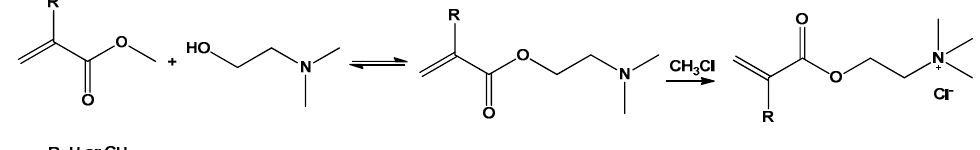
Figure 3. Synthesis routine of DAC (or